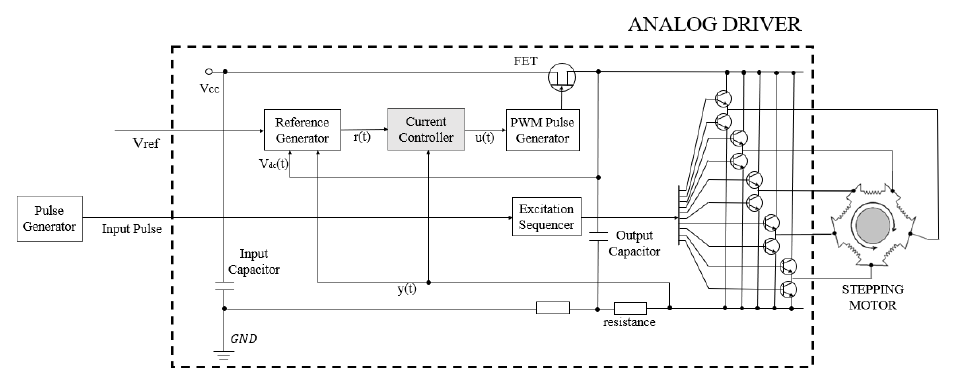
Figure 1. Connection between 5-phase stepping motor to the analog driver (The current controller is implemented by the DSP in the digital